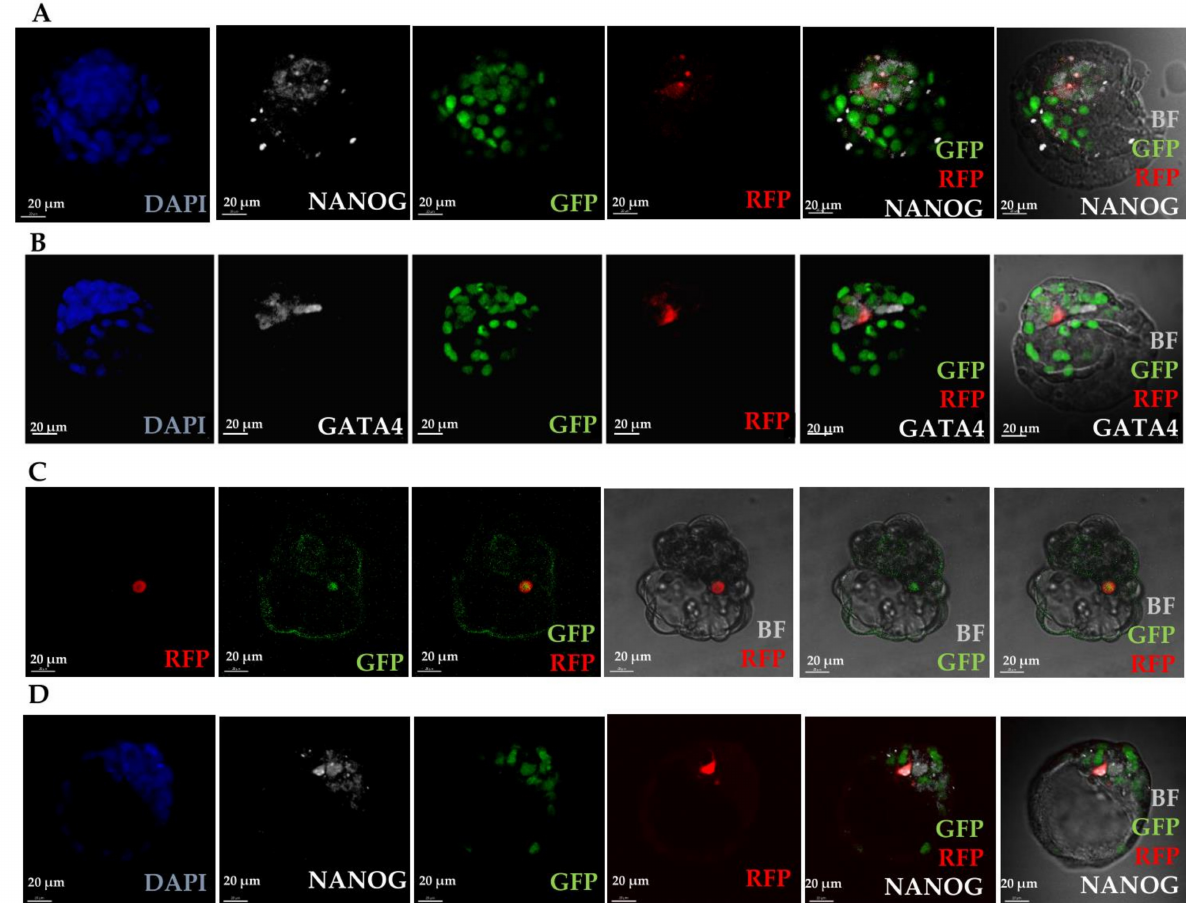
Figure 3. Expression of markers of blastocyst lineages in chimaeric blastocysts. Analysis of fusion of introduced cells and activation of GFP under the promoter of Oct4 . ( A ) Immunofluorescence staining of chimaeric blastocyst with MEF cell incorporated into epiblast and expressing RFP, GFP and NANOG. Recipient embryo is expressing GFP in all nuclei. Integrated cell expressing RFP and GFP is a product of fusion. ( B ) Immunofluorescence staining of chimaeric blastocyst with MEF cell incorporated into primitive endoderm, expressing RFP and GATA4, but not GFP. Introduced cell is reprogrammed to express GATA4, but is not a product of fusion. ( C ) Live fluorescence imaging of chimaeric blastocyst with MEF cell incorporated into primitive endoderm and expressing RFP and OCT4-GFP (GFP activated under the promoter of Oct4 ). ( D ) Immunofluorescence staining of chimaeric blastocyst with MEF cell incorporated into epiblast and expressing RFP and NANOG. Recipient embryo is expressing GFP in all nuclei. Integrated cell expressing RFP and NANOG, but is not a product of